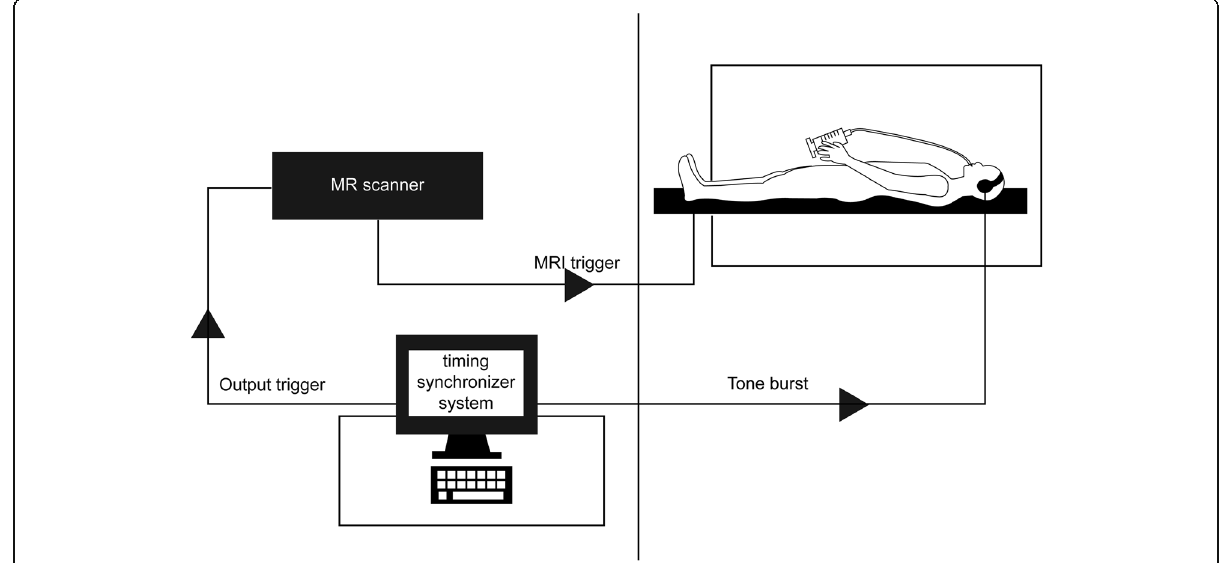
Fig. 1 Experimental settings for cine-magnetic resonance imaging